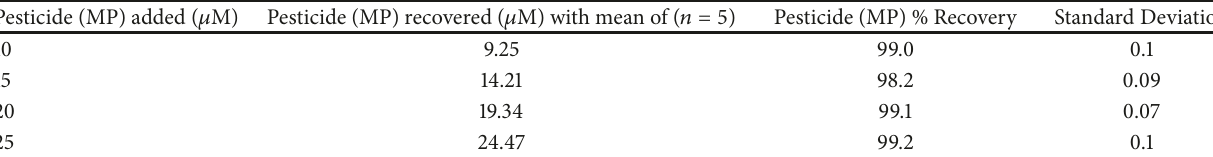
Table 1: Representing percent analytical recovery of Pesticide (MP) added and recovered.